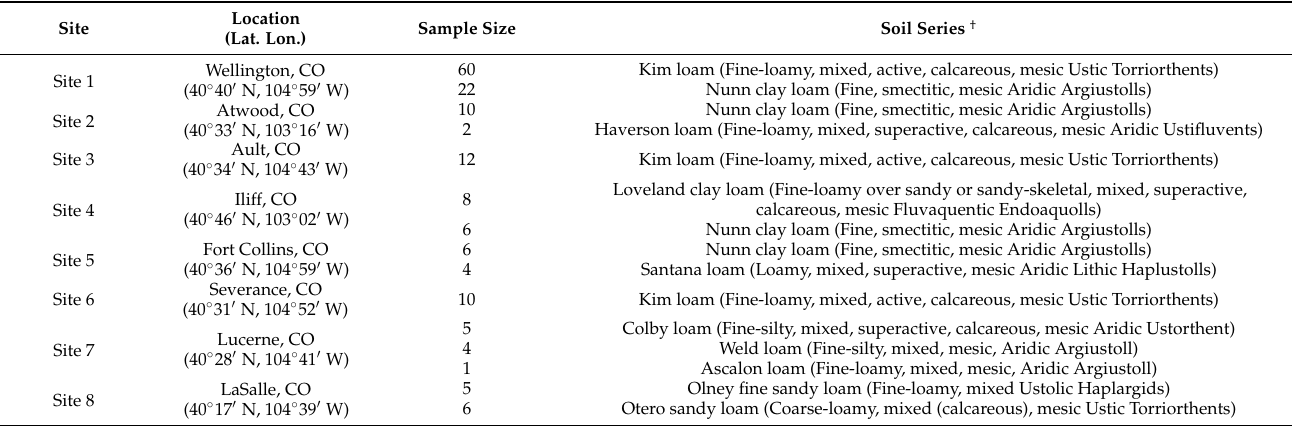
Table 1. Location and sample size acquired along with soil classification for each